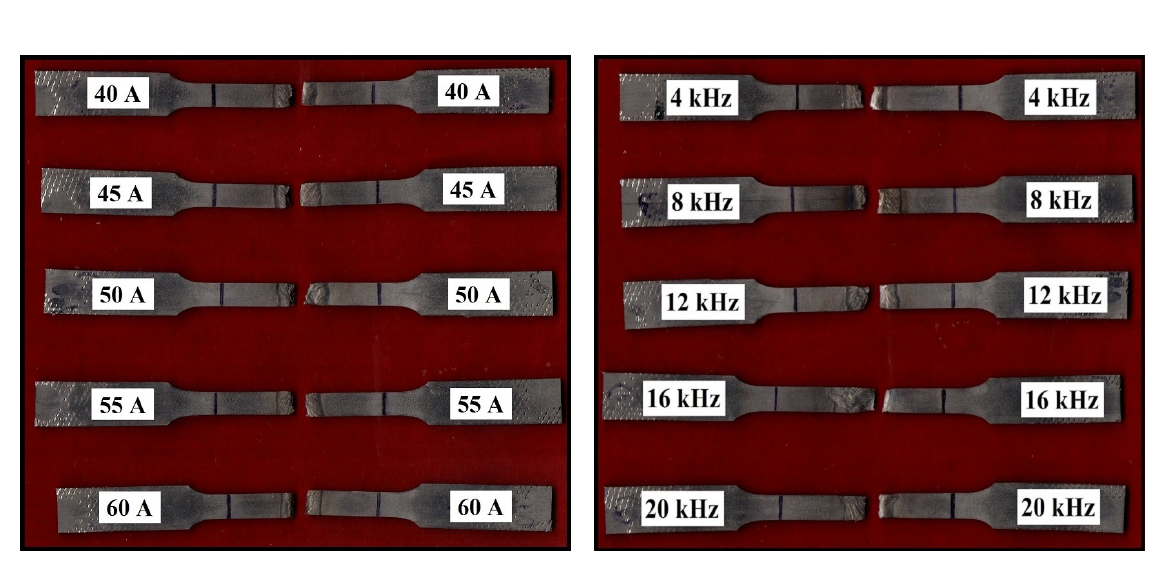
Figure 5: Photograph of tensile specimens after